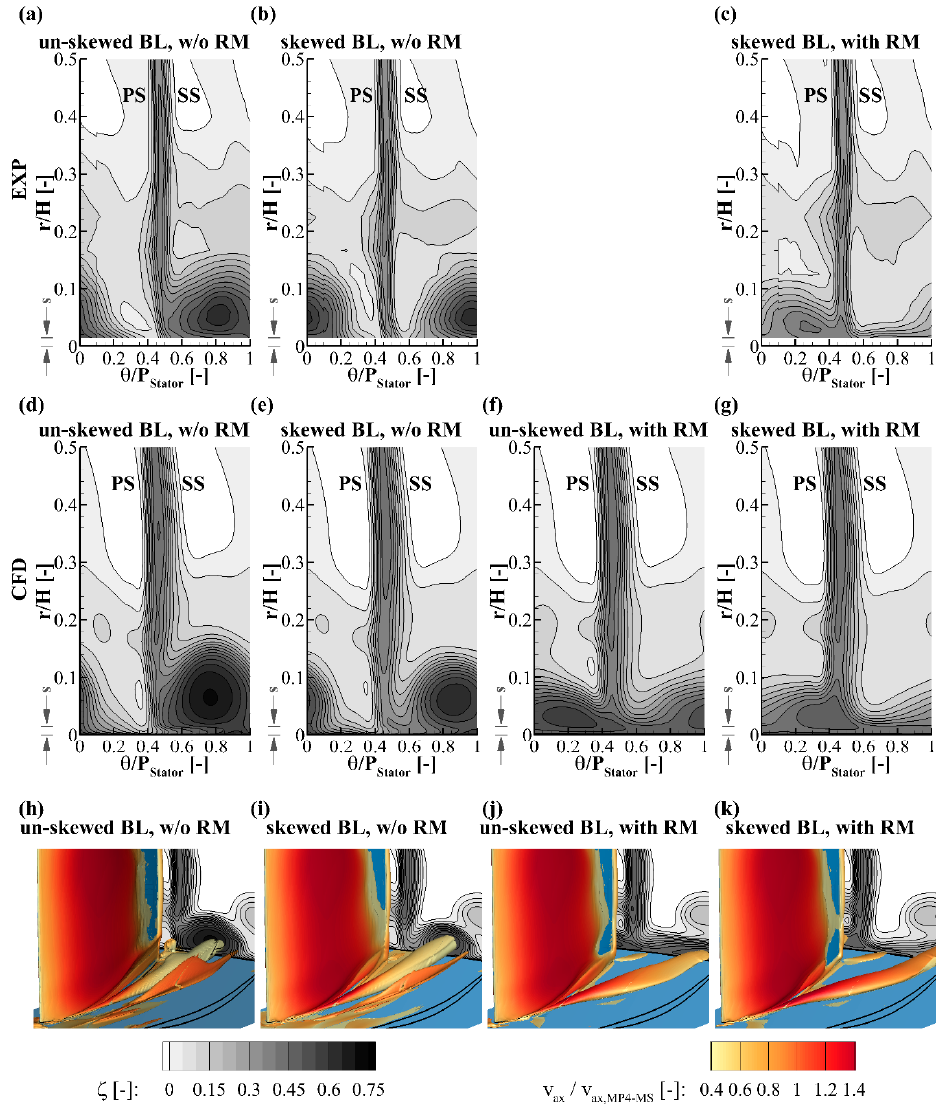
Figure 3. Effect of varying hub wall motion on non-dimensional total pressure loss coefficient downstream of S1 (MP5) ( a – c ) EXP, ( d – g ) CFD, and on the TLV trajectory ( λ (cid:2870) (〈v(cid:4652)⃗〉) = −10 (cid:2874) ) ( h – k ) downstream of S1 (MP5) ( a – c ) EXP, ( d – g ) CFD, and on the TLV trajectory ( λ 2 ( (cid:104) CFD, s/C = 2.0%. CFD, s/C =